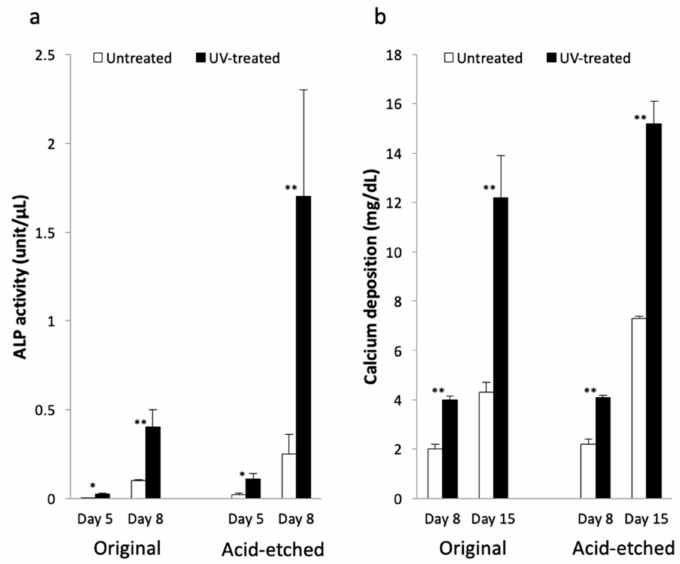
Figure 6. Results of ALP activity and mineralization. ( a ) ALP activity of the original and acid-etched Ti microfiber sca ff olds with or without UV-treatment at Days 5 and 8 of culture. ALP activity of osteoblasts in the UV-treated Ti microfiber sca ff olds is significantly greater than that of the untreated Ti microfiber sca ff olds. ( b ) Mineralization of original and acid-etched Ti microfiber sca ff olds with or without UV-treatment at Days 8 and 15 of culture. Mineralization of osteoblasts in the UV-treated Ti microfiber sca ff olds is significantly greater than that of untreated Ti microfiber sca ff olds. Each value represents the mean ± standard deviation of triplicate experiments ( n = 3). * p < 0.05, ** p <